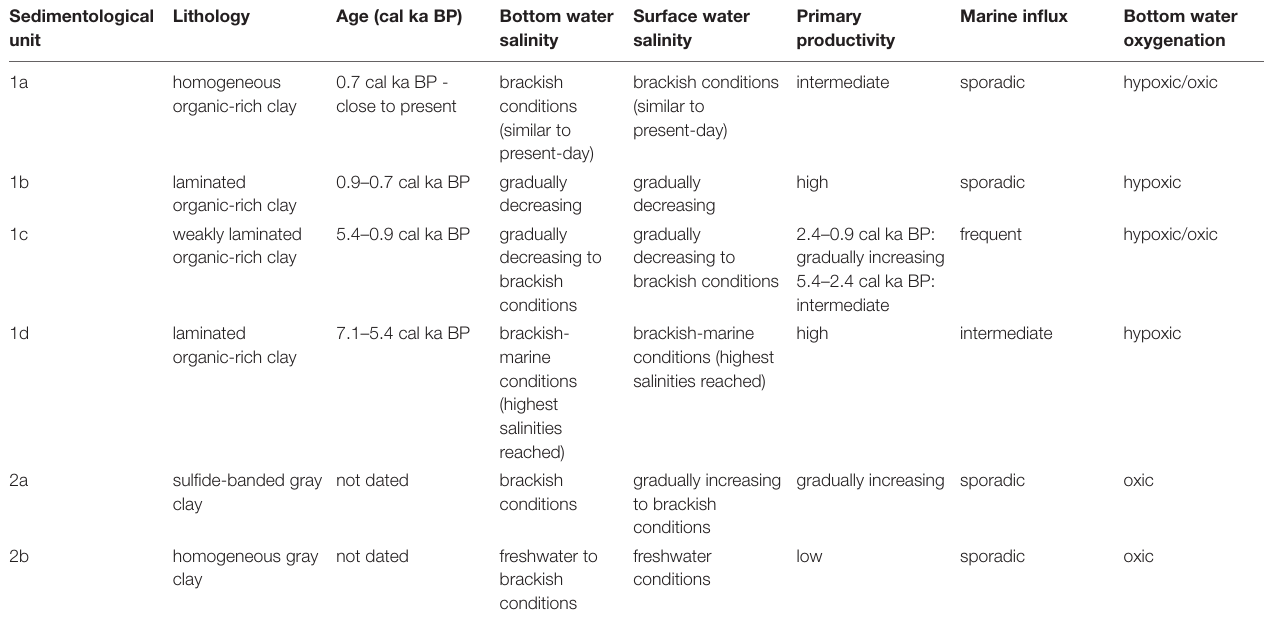
TABLE 2 | Summary of salinity, primary productivity and bottom water oxygenation interpretations for Integrated Ocean Drilling Program Expedition 347 site M0063. Sedimentological